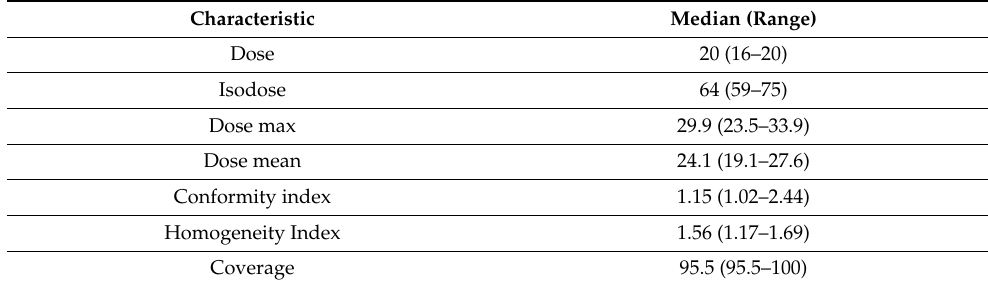
Table 2. Stereotactic radiosurgery characteristics.